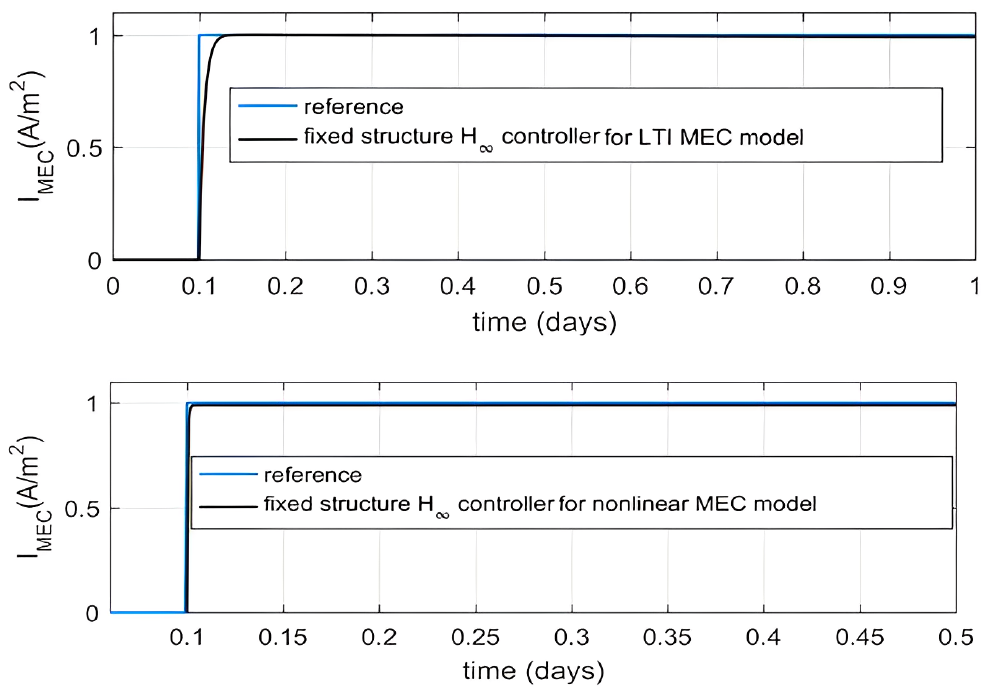
Figure 11. Plots of the proposed controller implementation for linear (first panel) and nonlinear (second panel) MEC process